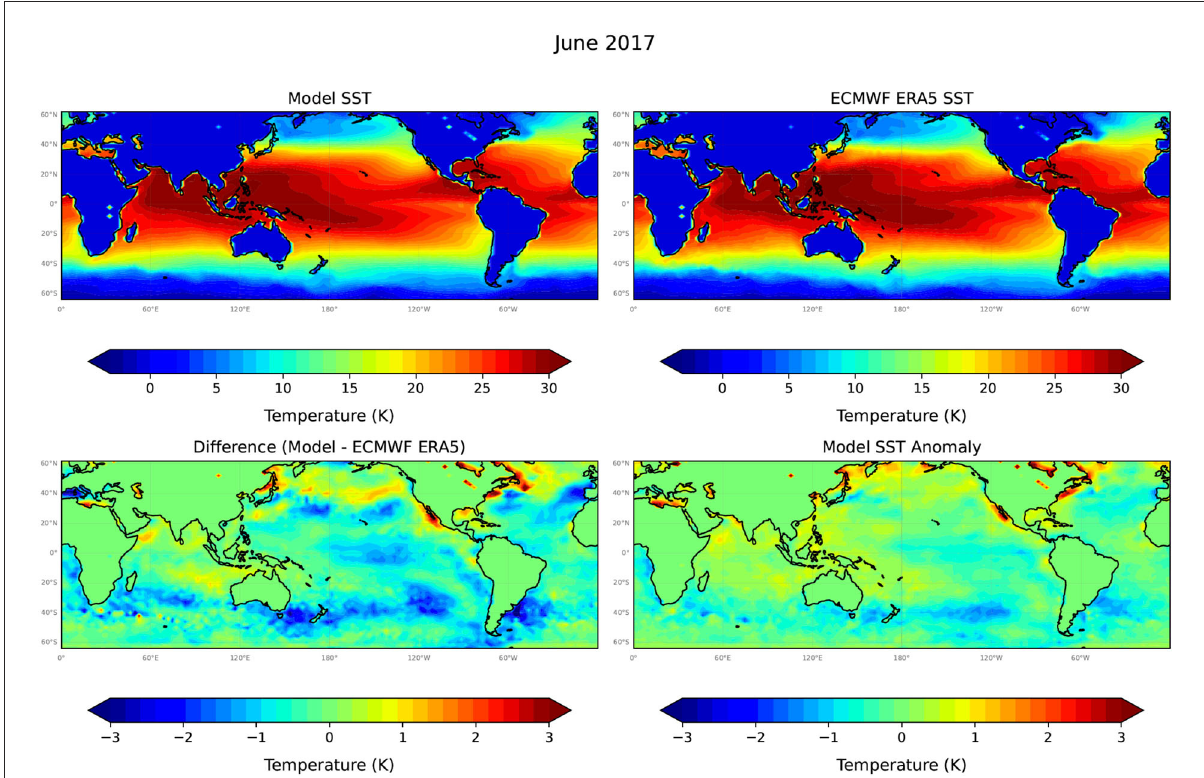
FIGURE7 Model predicted SST at +18 months (June 2017), from a model forecast initiated in December 2015, the corresponding target ERA5 SST data set, the difference between the model predictions and the target, and the model predicted SST anomaly. Note the different, much higher resolution temperature scale used to plot model differences and SST